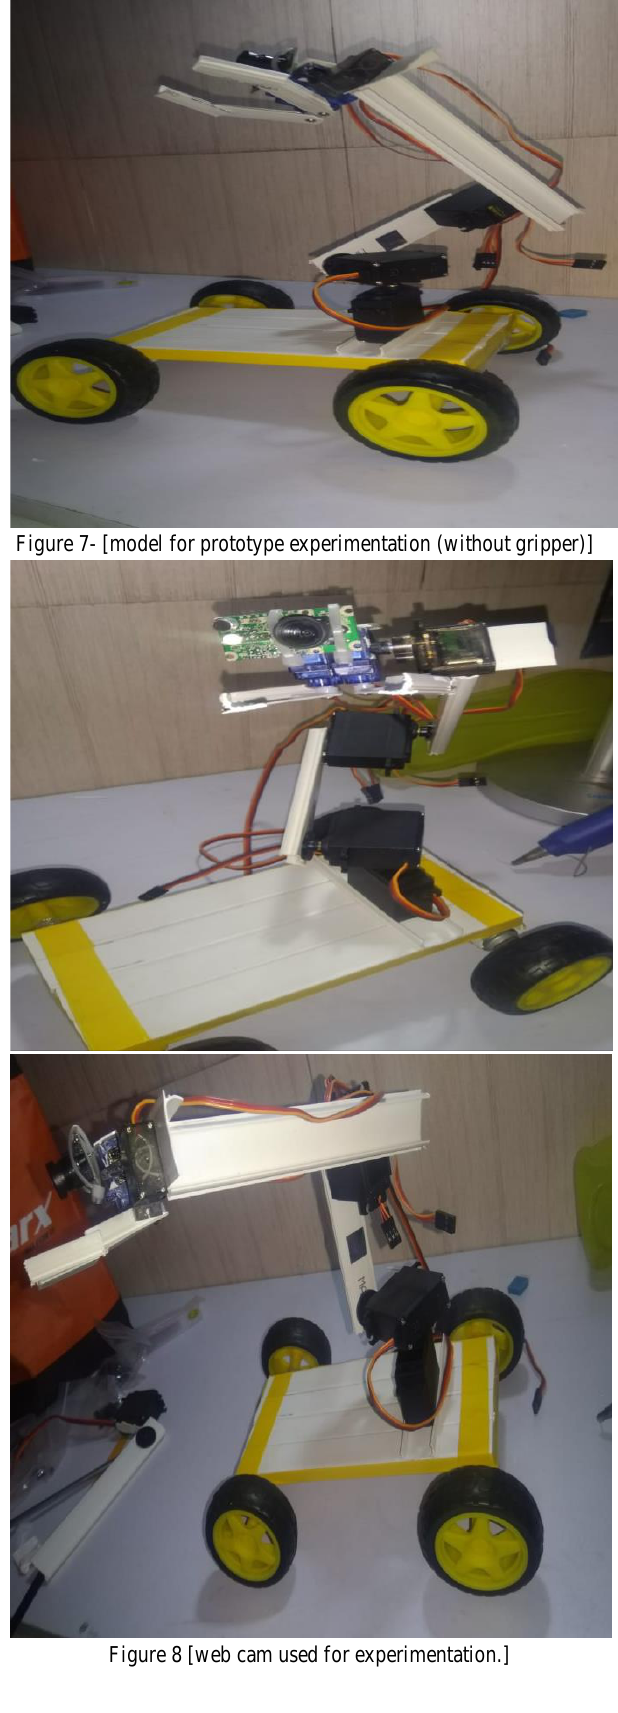
Figure 8 [web cam used for